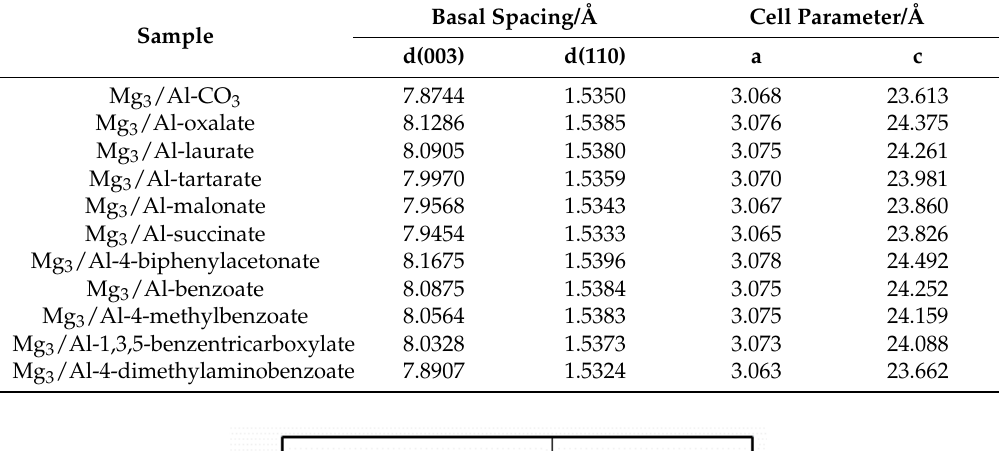
Table 1. The determined values of d spacing and lattice parameters of anion-intercalated Mg 3 /Al LDHs. The standard deviations for all measurements do not exceed ± 0.0005.